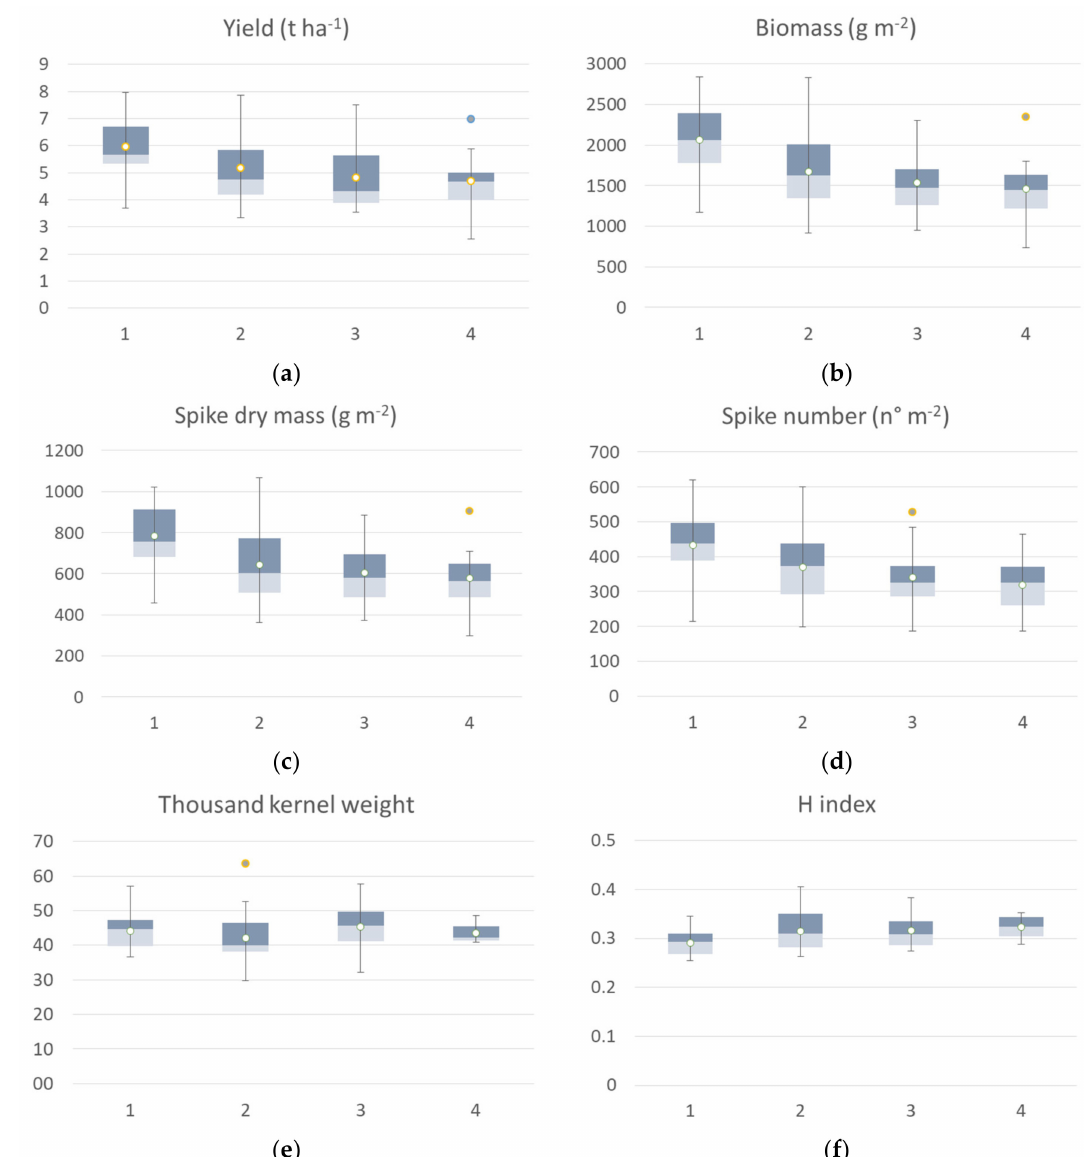
Figure 7. Box plot of agronomic traits collected at harvest: yield ( a ), biomass ( b ), spike weight ( c ), spike numbers ( d ), thousand-kernel weight ( e ) and H index ( f ) of the seven durum wheat cultivars grouped according to the four identified VI clusters at tillering. All the components showed a significant difference among clusters, and thousand kernel weight showed no significant differences among clusters (Kruskal–Wallis